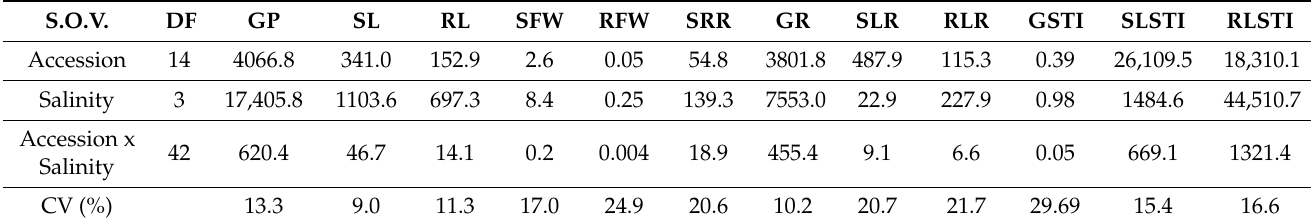
Table 1. Analysis of variance (mean of squares) for traits related to seed germination and seeding growth in squash germplasm (accession) under different salt stress conditions (Salinity).